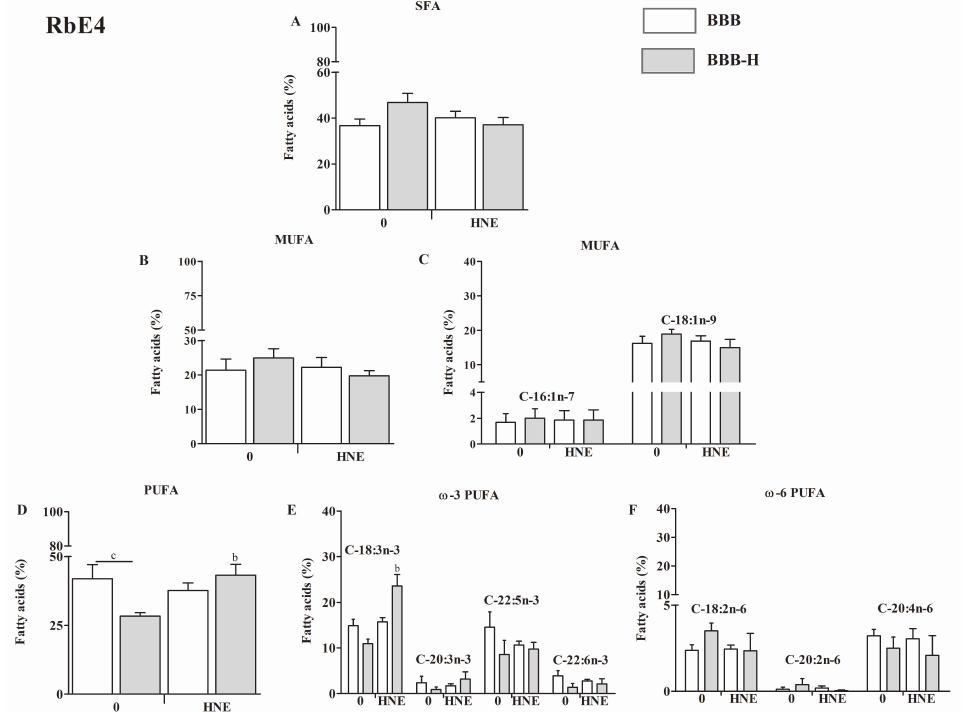
Figure 5. Fatty acid composition of RbE4 cells of BBB and BBB-H model at control conditions (0) and 20 µ M HNE treatment based on the degree of saturation: saturated fatty acids (SFA) composition ( A ); monounsaturated fatty acids (MUFA) composition with major representatives ( B , C ); polyunsaturated fatty acids (PUFA) composition with major ω 3 and ω 6 representatives ( D – F ). All results are repre- sented as mean ± SEM, n = 4 samples for each group from 2 independent experiments. b—statistically significant in respect to control (0) on modified collagen, p < 0.01; c—statistically significant between groups of same treatment, p <